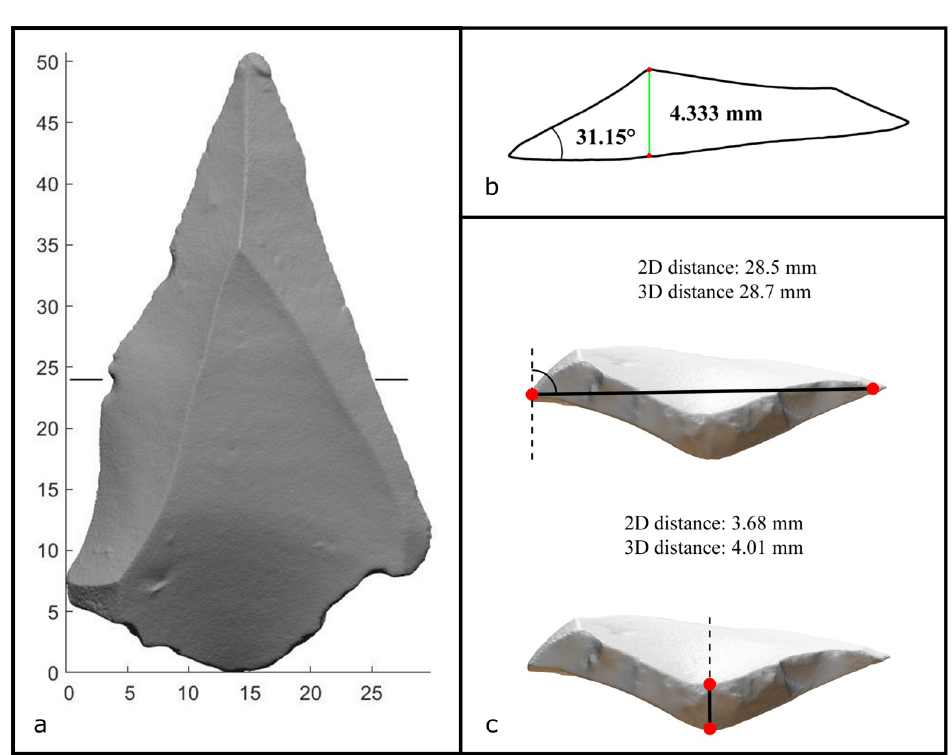
Fig 4. The 3D model of the Levallois flake showing the location of the cut made using the Create Cut function (a). The angle and length measurements taken on this cut (b). The platform width and depth distances taken using the Manual Measurements function